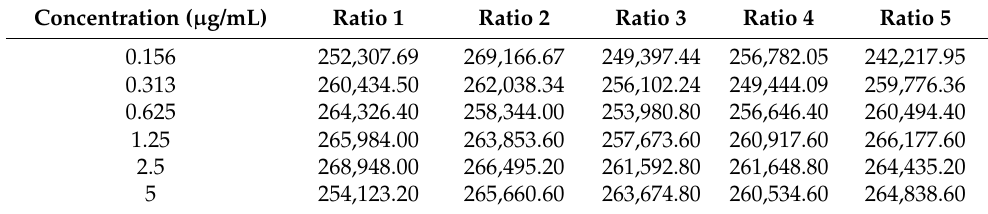
Table 3. Standard APR curve and respective area response factor. Low range.